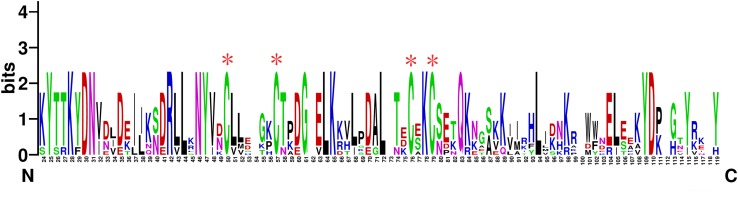
The WebLogo alignment of OcomCSP12 and five other CSPs of coleopteran insects. ∗Four highly homologous cysteines; N, N-terminal, C, C-terminal.